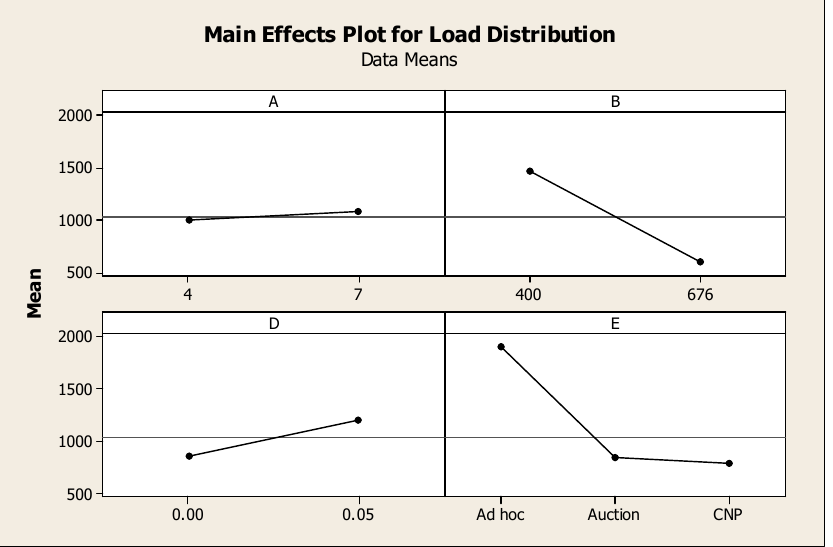
Figure 6. Main effect plot for load distribution. n = 160, ANOVA, 1 df , p < 0.05.